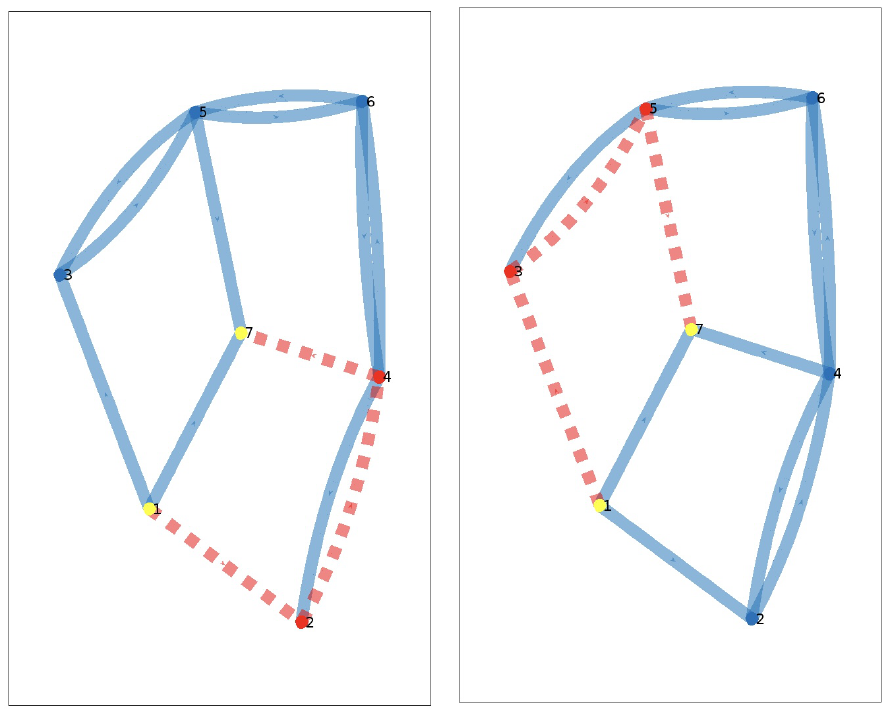
Figure 7. ( Left ): the optimal path (1,3,5,7) (in red) corresponding to Case 4. ( Right ): the alternative optimal path through the sequence of nodes